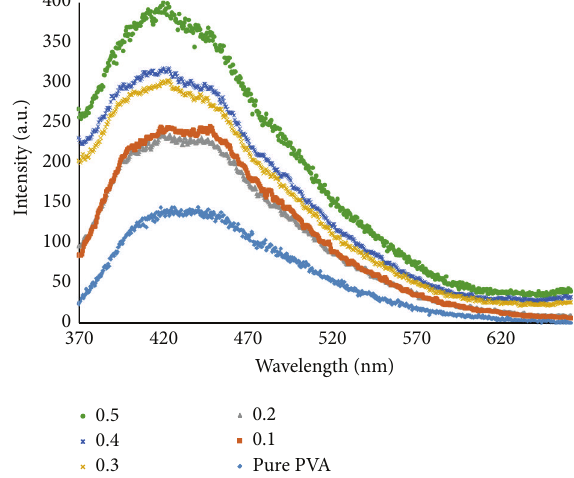
Figure 5: PL spectra of pure PVA and PPVA films with five mole ratios (0.1, 0.2, 0.3, 0.4, and 0.5) at an excitation wavelength of 350